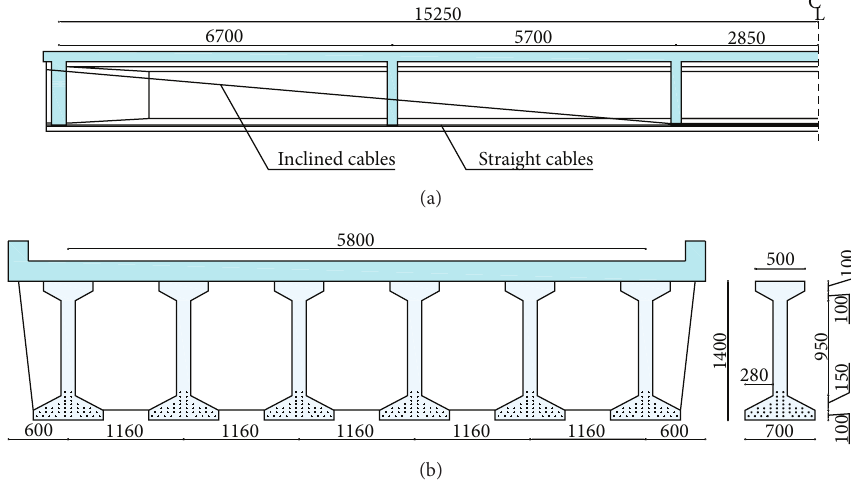
Figure 2: (a) Longitudinal and (b) transversal scheme of existing